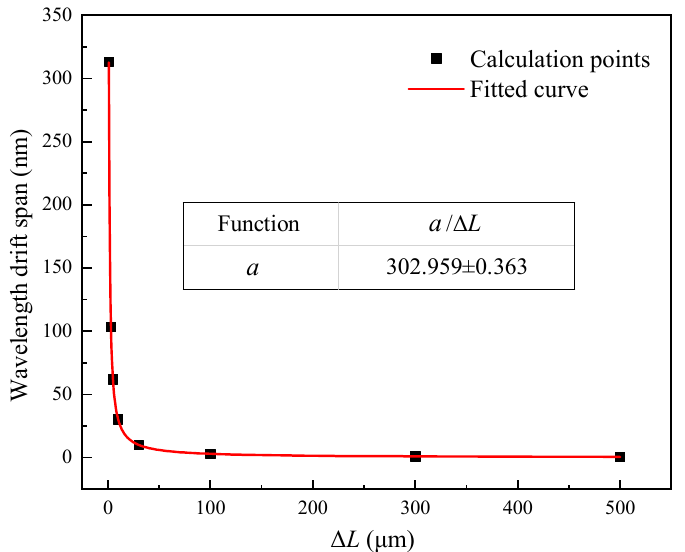
Figure 8. Fitted relationship between the step height and the permissible wavelength drift span.